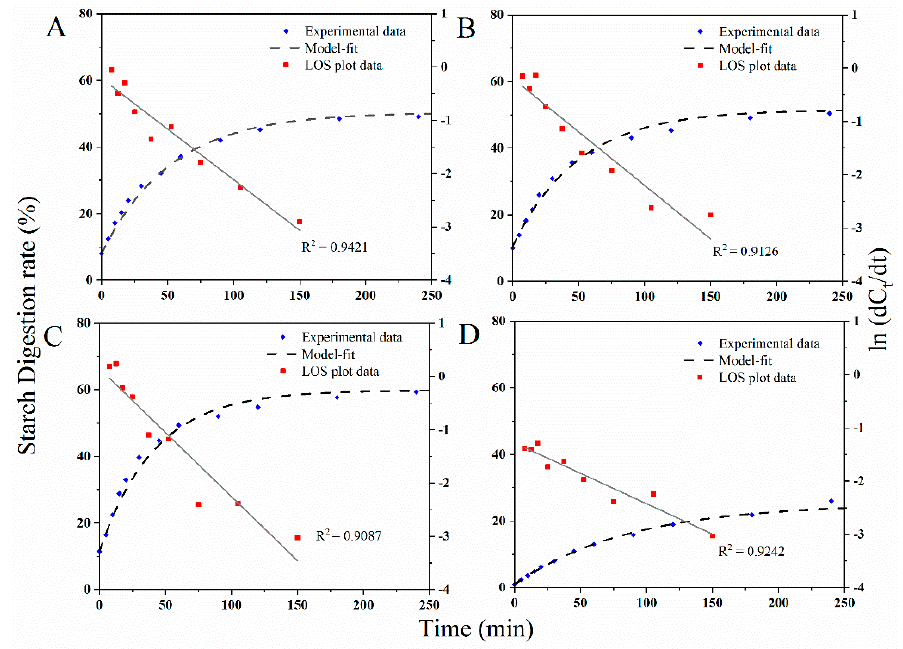
Figure 7. Starch digestion curves, LOS plots, and model-fit curves of M1 with different processing treatments. ( A – D ) represents raw millet, soaked millet, steamed millet, and baked millet, respectively.